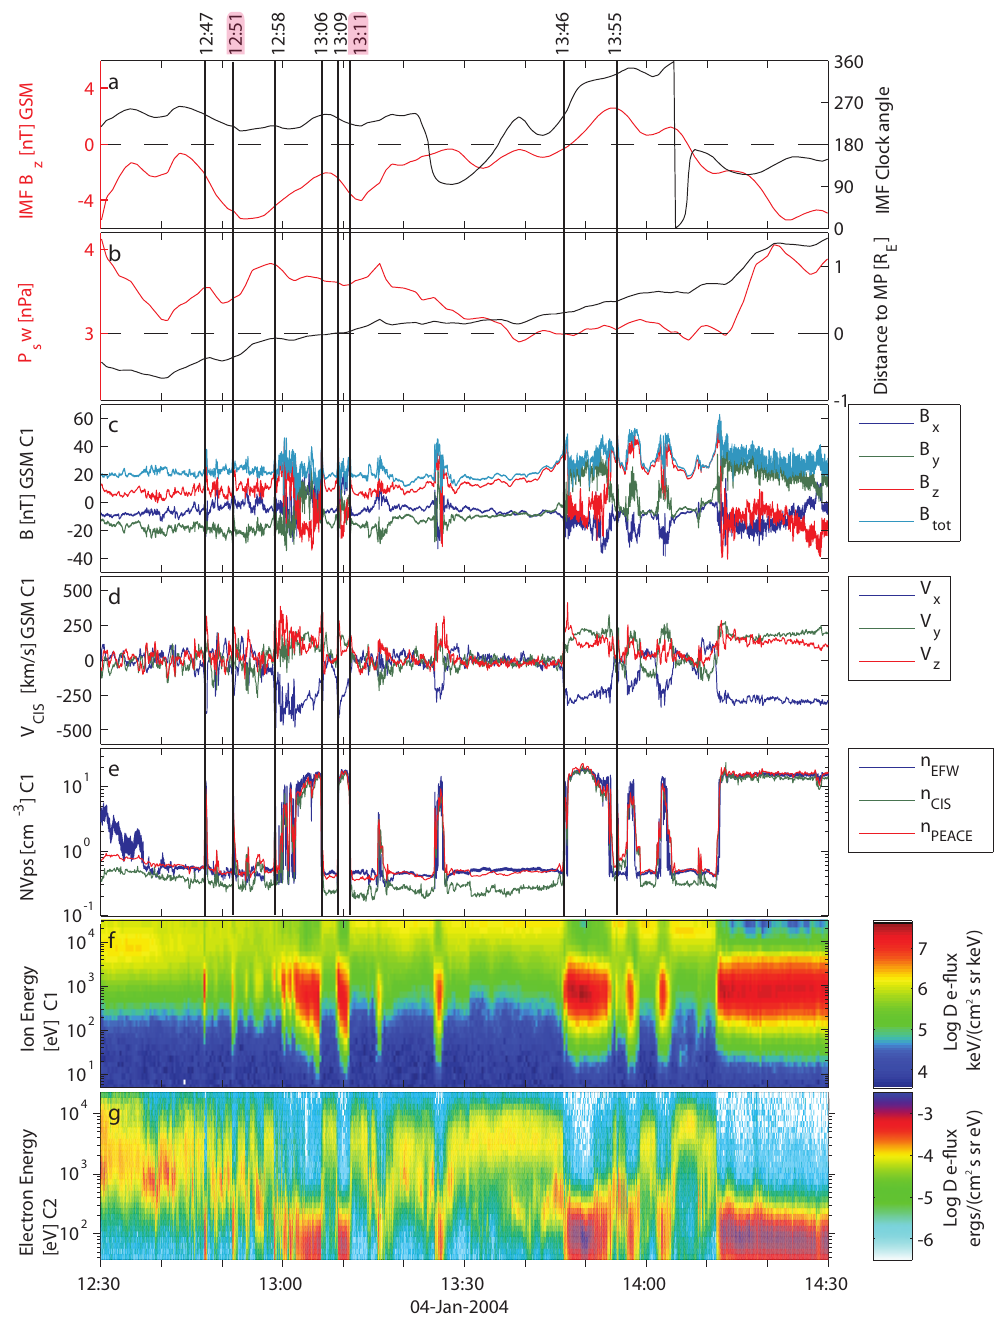
Fig. 3. Overview of the Cluster magnetopause crossing on 4 January 2004, 12:30–14:30UT from SC1. Panel (a) shows the interplanetary magnetic field (IMF) B z and the clock angle observed by the ACE spacecraft. Panel (b) shows the solar wind pressure and the estimated distance to the magnetopause. Panels (c–g) contain data from Cluster. Panel (c) shows the GSM components and magnitude of the mag- netic field. Panel (d) shows the ion velocity in GSM coordinates. Panel (e) shows three different plasma density estimates based on the spacecraft potential, electron instrument PEACE and ion instrument CIS data. Panel (f) shows the ion differential energy flux spectrogram. Panel (g) shows the electron differential energy flux spectrogram. The vertical lines mark sub-intervals which are analyzed in detail and summarized in Table 1. Details for the sub-intervals marked in pink are shown in Figs. 8 and